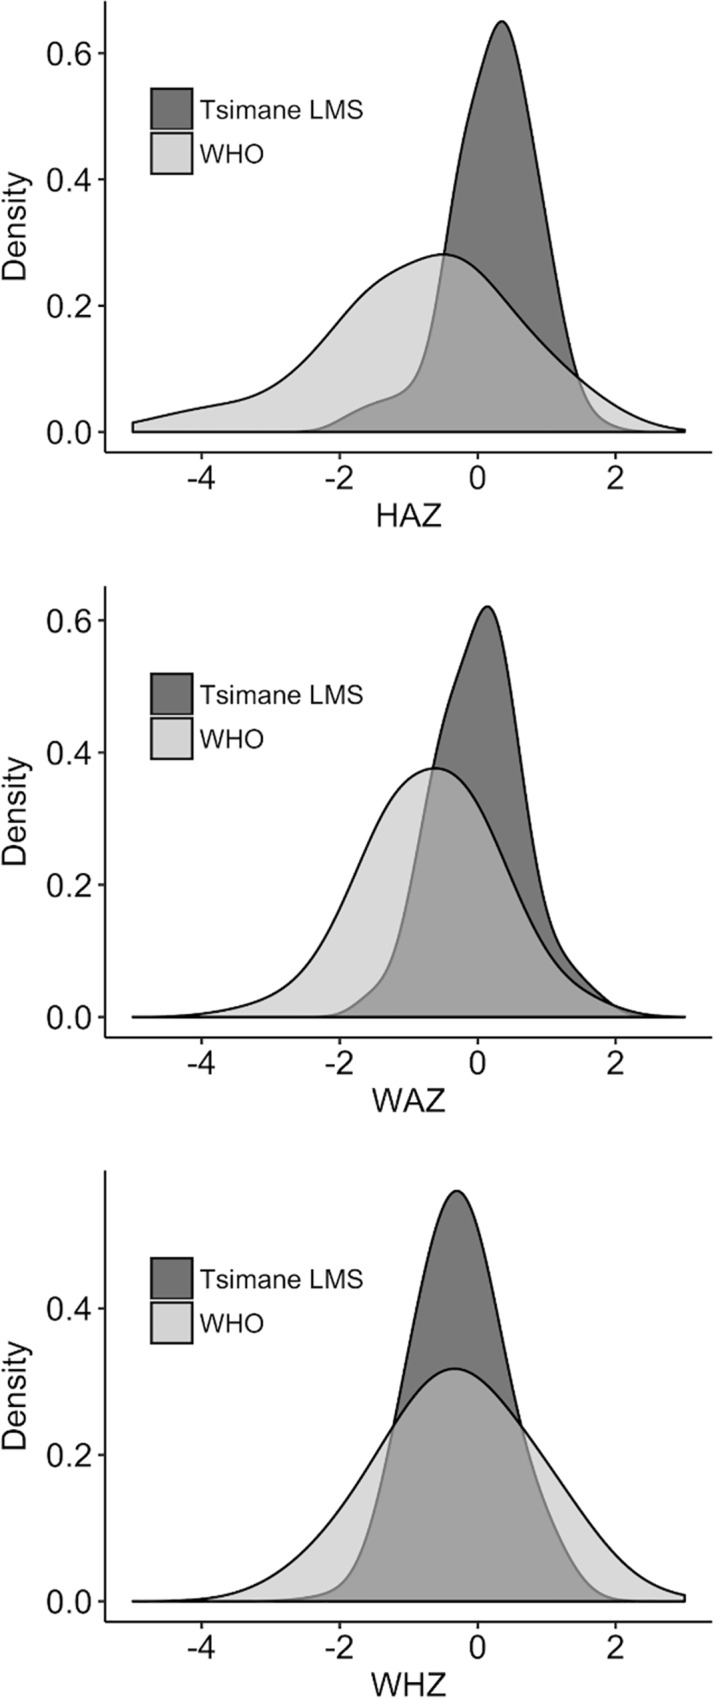
A-C. Density plots of WHO- and Tsimane LMS-derived HAZ, WAZ, and WHZ scores. Plots reflect measures collected from all subjects aged 0–35 months (n subjects = 156; n observations = 287). Fig 1A HAZ (top); Fig 1B WAZ (middle); Fig 1C WHZ (bottom).